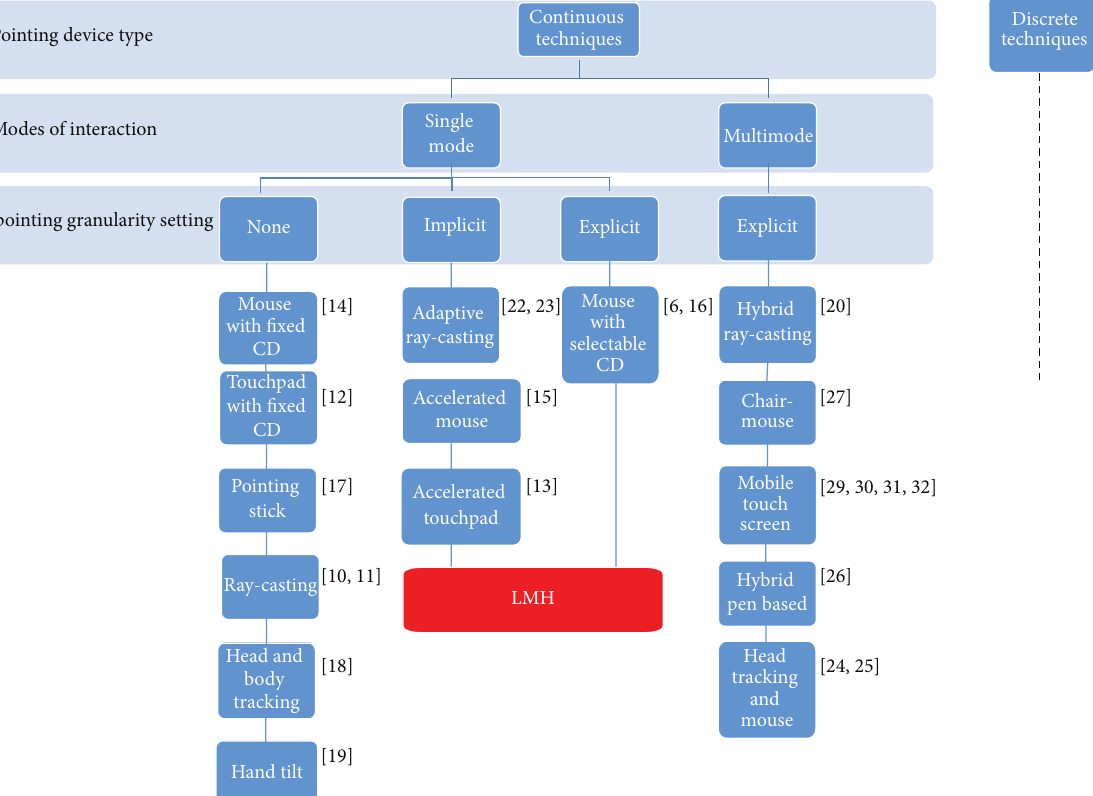
Figure 2: Categories of pointer interaction techniques for large displays, with prominent examples in each category. Multifinger LMH defines a new category of techniques that combine both explicit and implicit pointer granularity